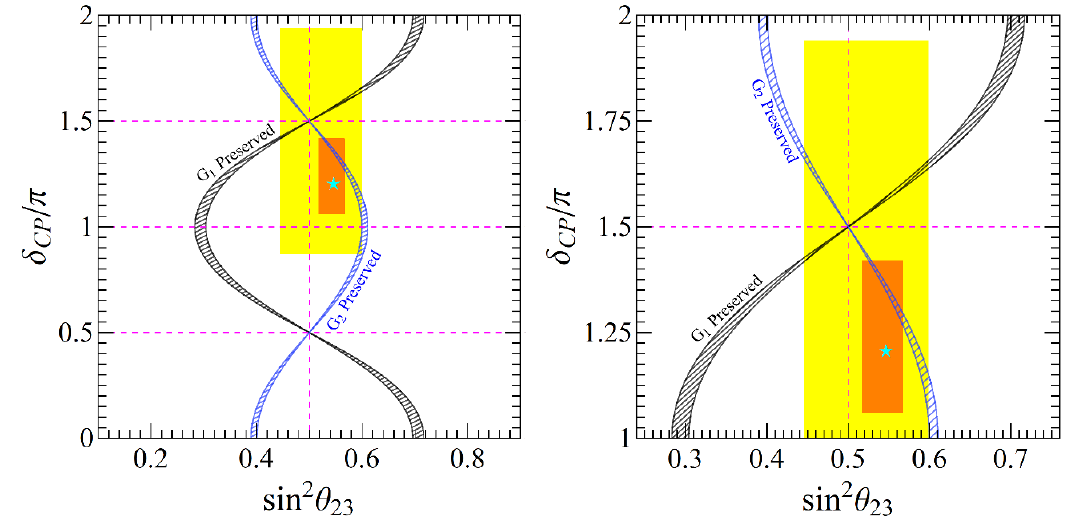
Figure 2 . Predicted correlation between sin 2 (cid:18) 23 and (cid:14) CP . The black region corresponds to the case where G 1 is preserved by the neutrino sector, as given from (eq. (4.15), right), when (cid:18) 13 is running in the 3 (cid:27) allowed region. Analogously, the blue region corresponds to the case where G 2 is preserved by the neutrino sector, as given by (eq. (4.34), right). The right panel is a zoom of the left one. The shaded regions are the current 1 (cid:27) and 3 (cid:27) ranges for the case of normal ordering [6].